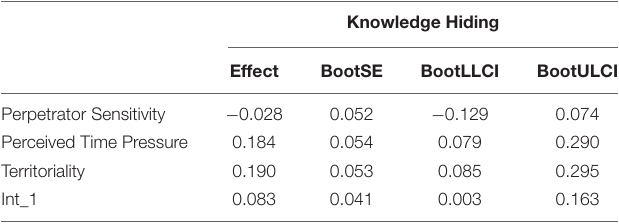
TABLE 9 | Moderated mediating regression coefficients and significance of perpetrator sensitivity.